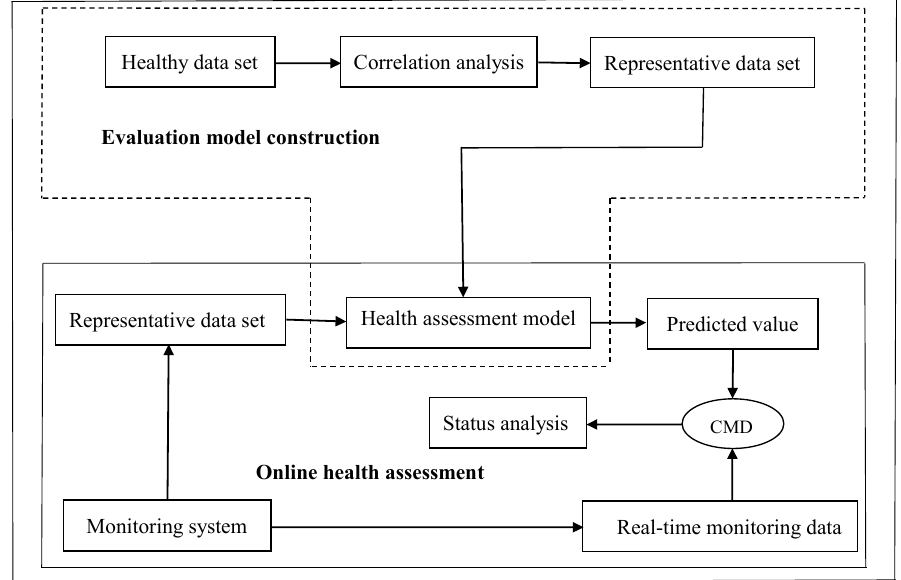
Figure 1. The proposed health assessment framework for hydropower units.